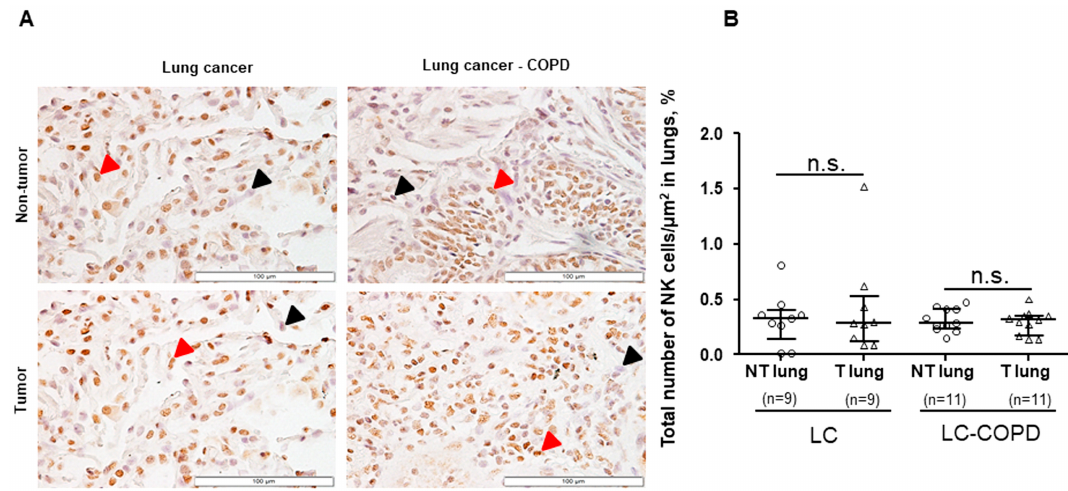
Figure 2. ( A ) Representative examples of double immunohistochemical staining for NK cells (NCR1 + ) in LC and LC–COPD patients, respectively. Black arrows point toward NK cells negatively stained in blue with hematoxylin, and red arrows point toward NK cells (NCR1 + ) stained in brown. ( B ) Median and interquartile ranges between 75th and 25th percentiles of proportions of NK cells in the total measured area. Comparisons were made between the non-tumor (NT) and tumor (T) samples and the LC and LC–COPD groups. For technical reasons, the number of patients in each group or type of samples (tumor and non-tumor) may di ff er. Statistical significance: n.s. No significance between tumor and non-tumor lungs in either LC or LC–COPD patients. Definition of abbreviations: LC, lung cancer; COPD, chronic obstructive pulmonary disease; CD, cluster of di ff erentiation, NK, natural killer; NCR1, natural cytotoxicity triggering receptor